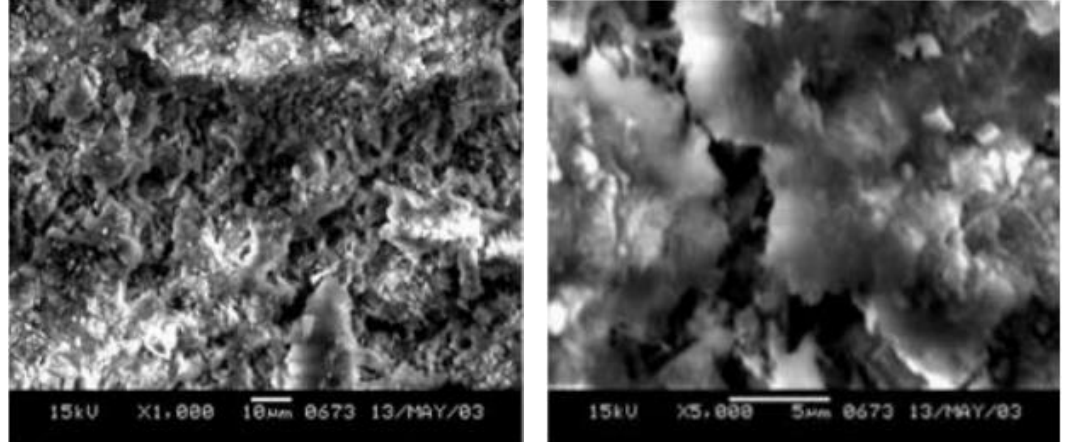
Figure 7: Interface of different test piece [103]